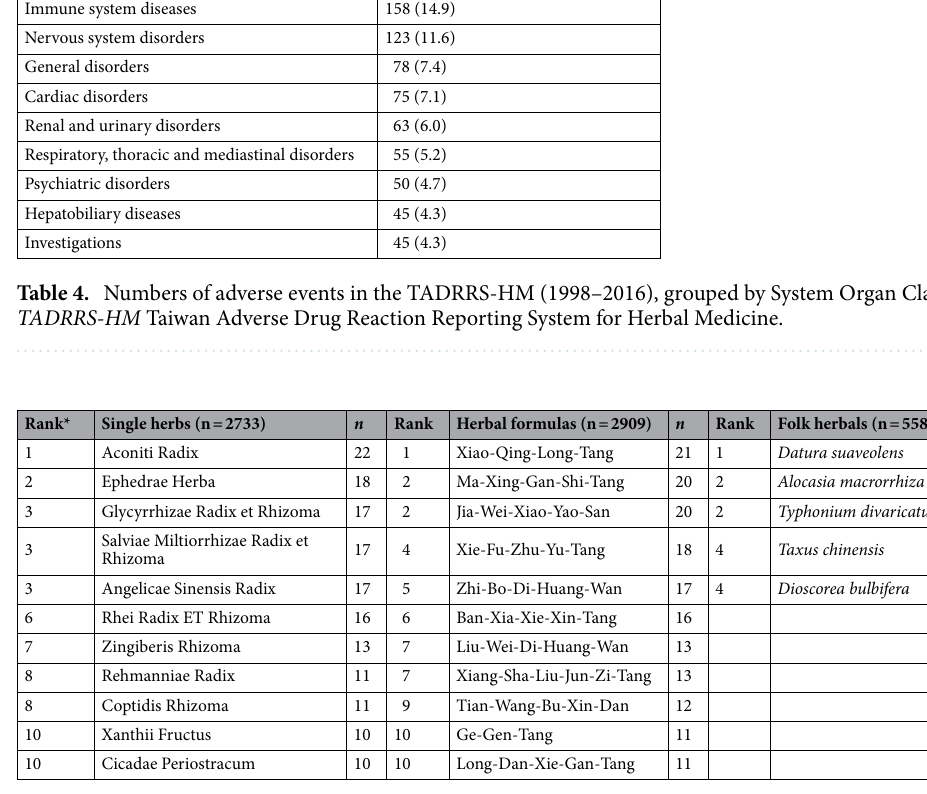
Table 5. The top 10 frequently reported herbals and formulas in TADRRS-HM, 1998–2016. TADRRS-HM Taiwan Adverse Drug Reaction Reporting System for Herbal Medicine. *Frequency of reports involving suspected herbal substances with a Naranjo scale score of ≥ 1 (a score of 1–4 is considered "possible", 5–8 "probable", and ≥ 9 "definite", as to the likelihood of the herb causing the ADR) 24 .